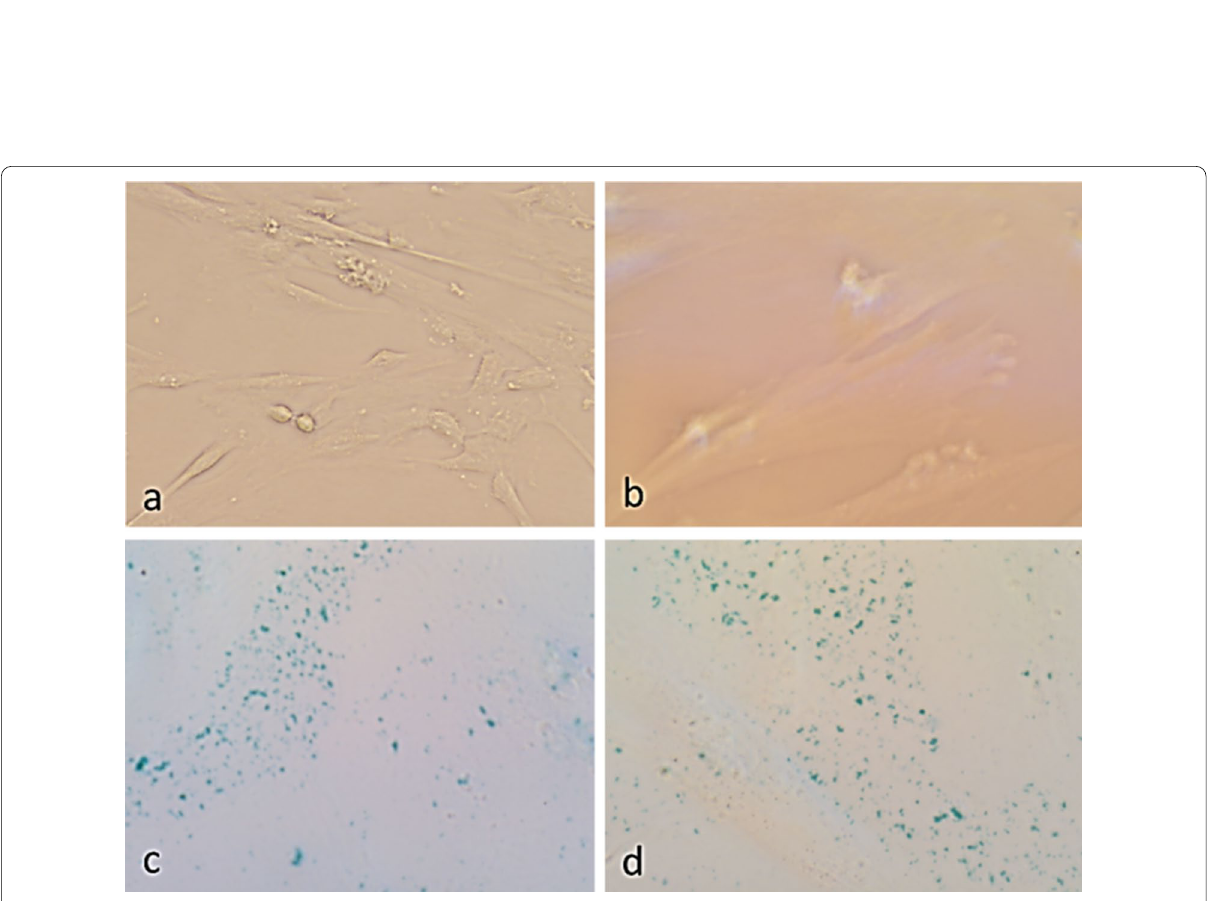
Fig. 9 After staining: a Control flask (20X Magnification, Phase contrast 2); b Control flask (40X Magnification, Phase contrast 3); c and d Glycosaminoglycan presence in experimental flask shown by the blue stains (40X Magnification, Phase contrast 3) as observed under inverted microscope Olympus